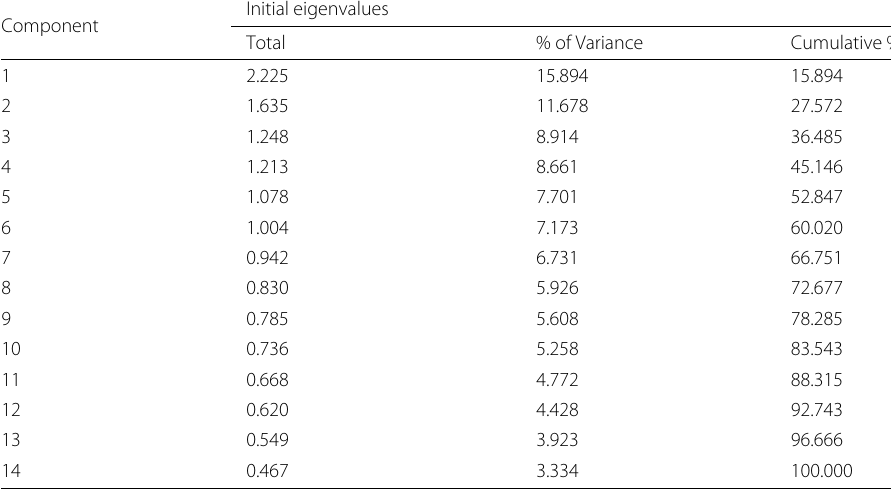
Table 8 Total variance explained by each component in test-one Initial eigenvalues Component Total % of Variance Cumulative %